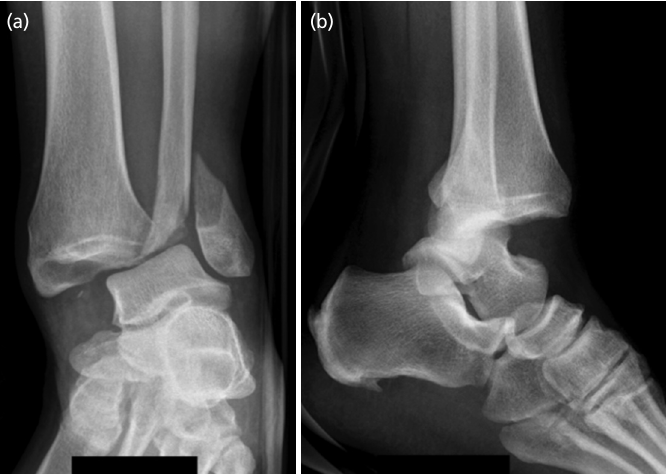
Fig. 3: Patient 2 – Pre-reduction (a) antero-posterior and (b) lateral radiographs of the ankle illustrating a Weber type B lateral malleolus fracture and dislocation of the ankle